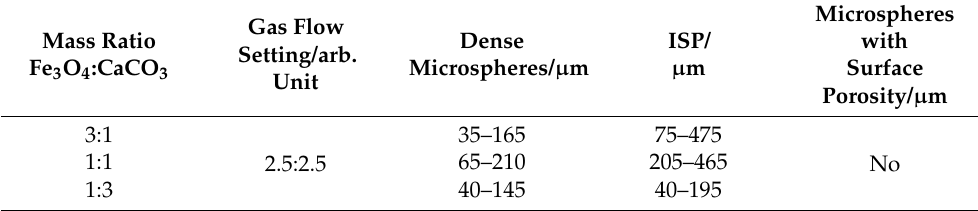
Table 1. Size range of flam-spheroidised reaction products (dense microspheres, irregular-shaped particles (ISP), and microspheres with surface porosity), as a function of precursor to porogen mass ratio.